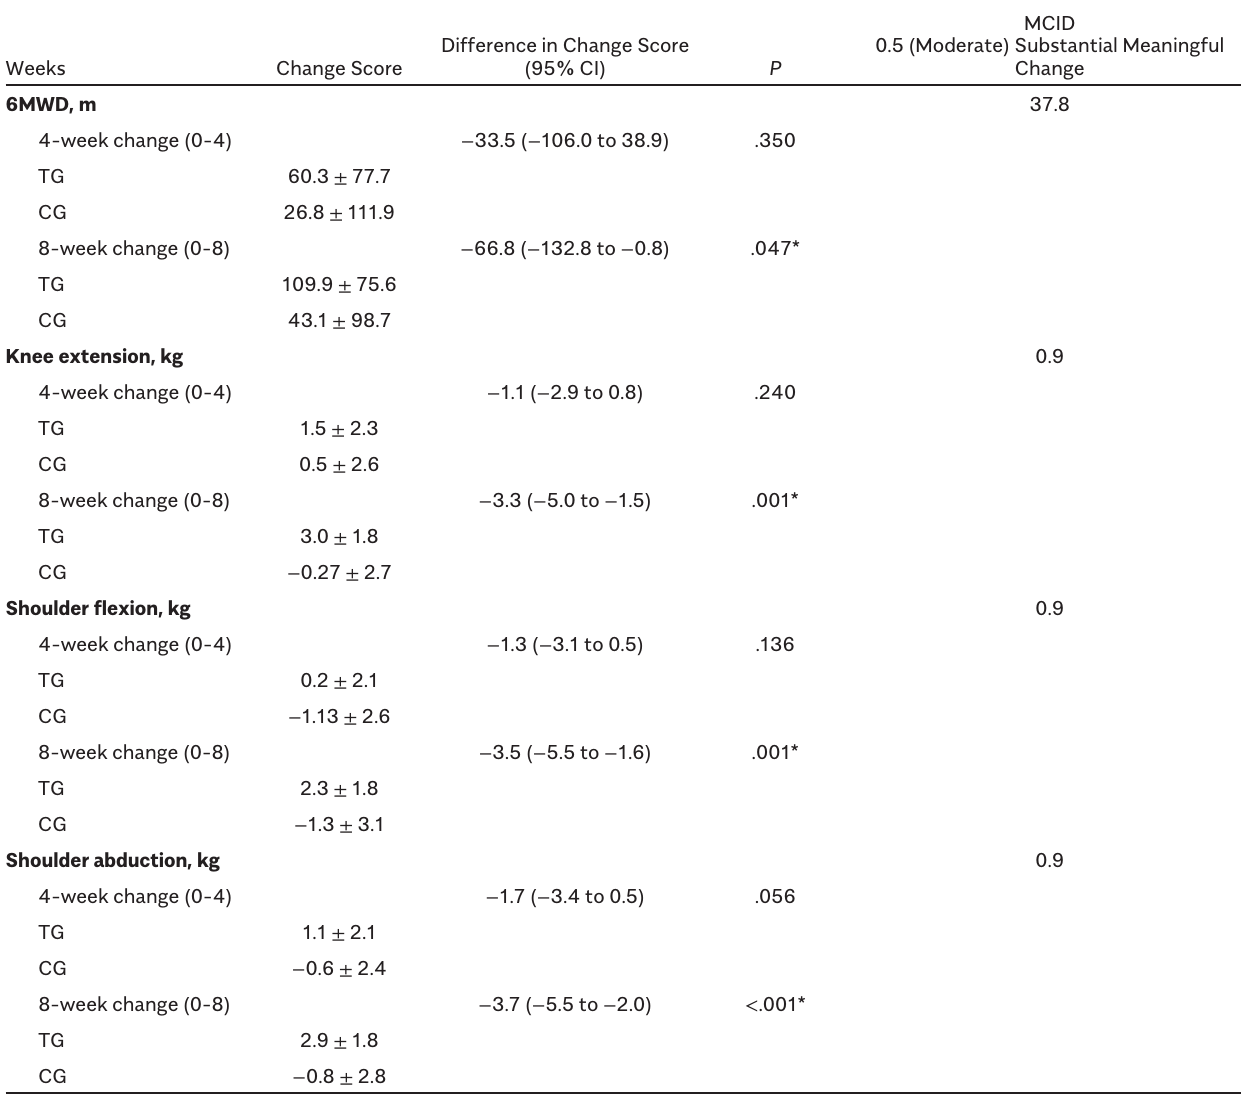
Table 3. Effect of Early Resistance Training on 6MWD and Muscle Strength Pretransplant, and 4 Weeks and 8 Weeks Posttransplant for Subjects in the TG (n = 15) and CG (n =